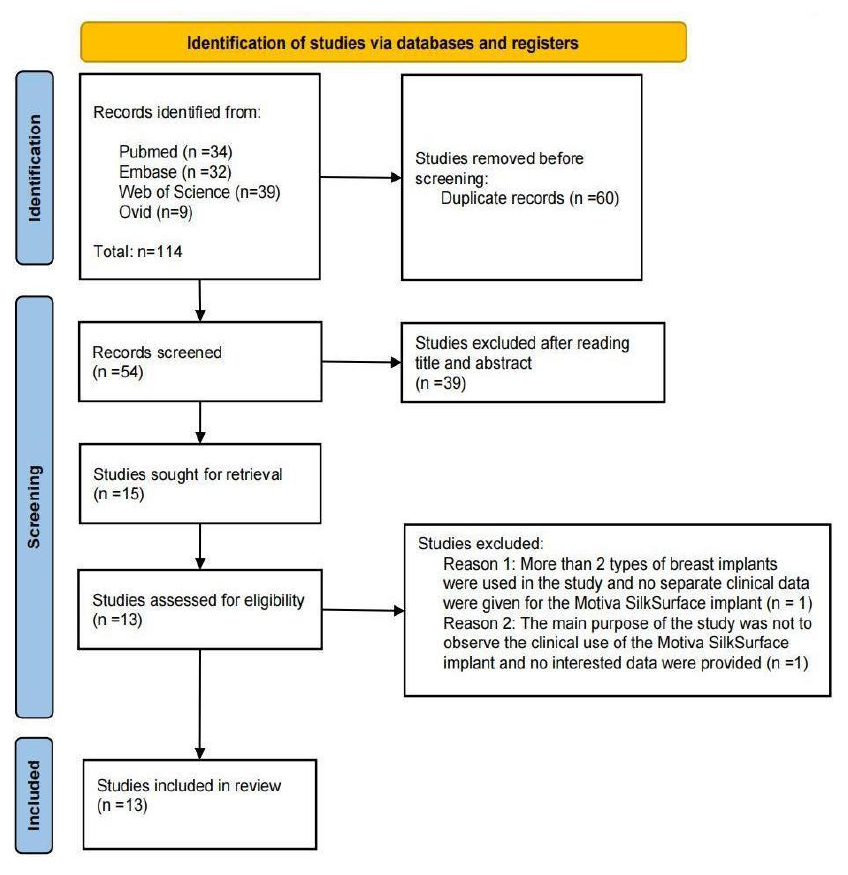
Figure 2. Flow diagram of the literature search and selection (PRISMA compliant flow chart.).